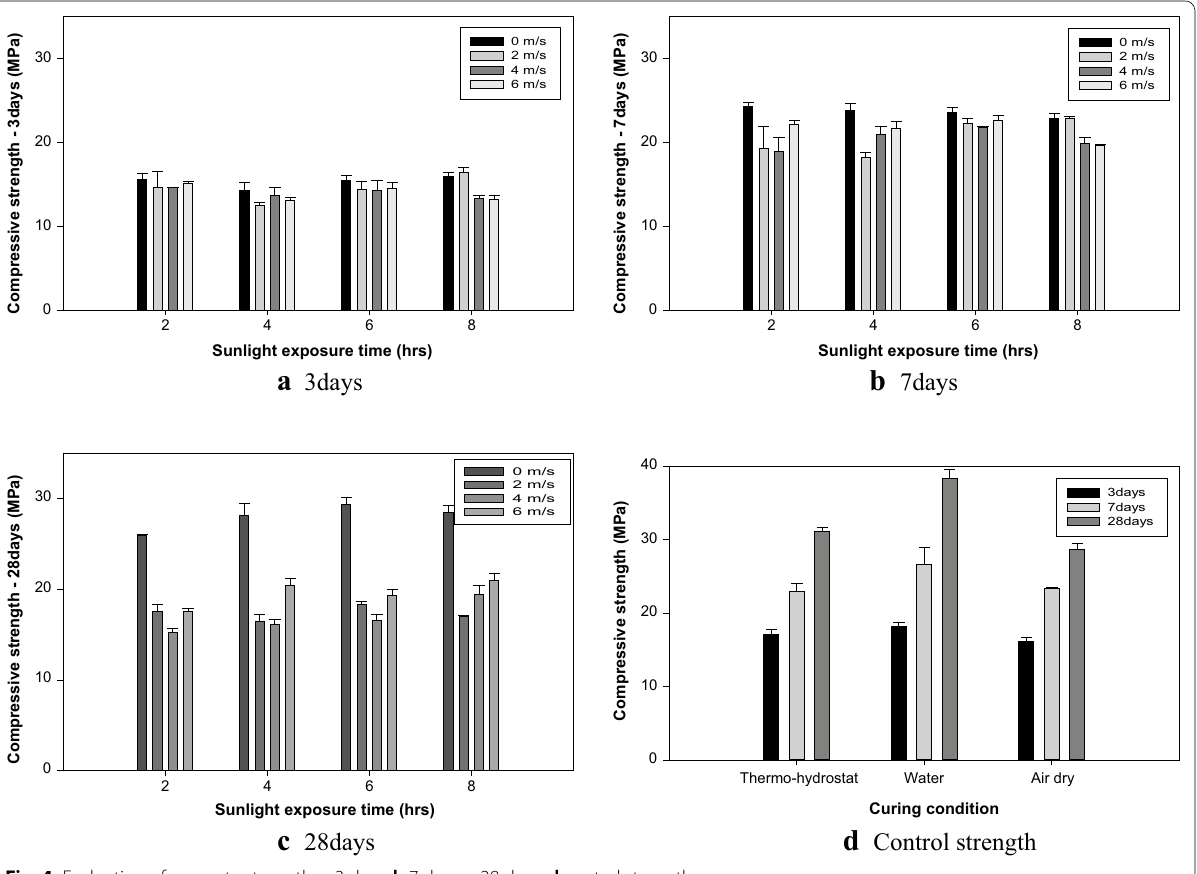
Fig. 4 Evaluation of concrete strength: a 3 days, b 7 days, c 28 days, d control strength.